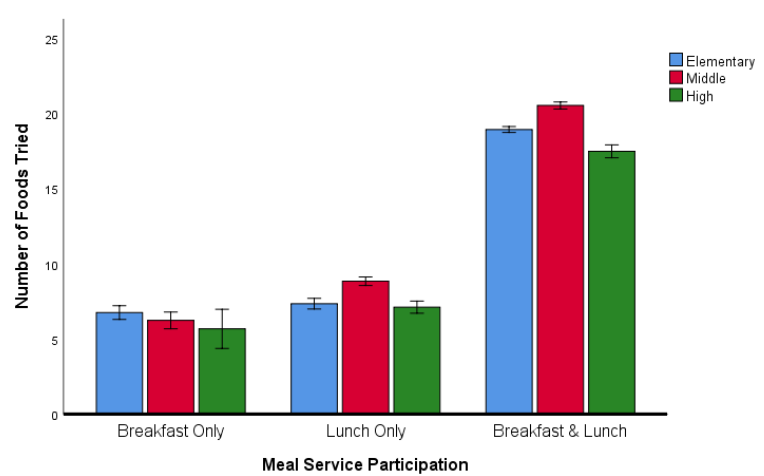
Figure 1. Number of foods tried by different grade groups within meal service participation level. Values are means with 95% CI indicated by vertical bars.